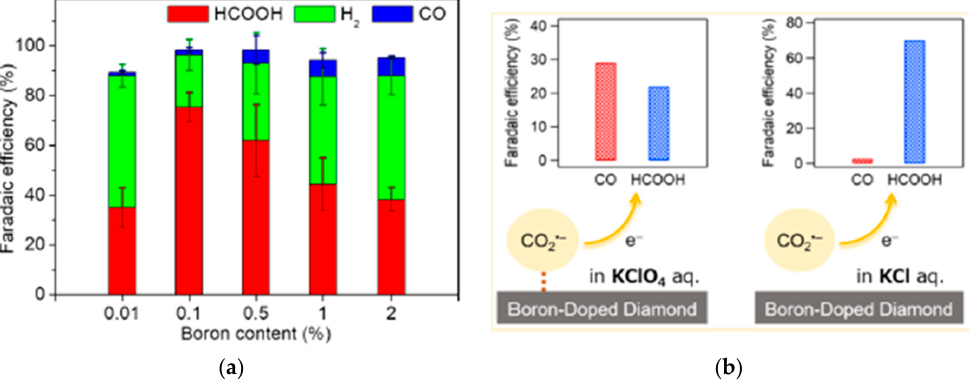
Figure 3. ( a ) Faradaic e ffi ciencies to formic acid, hydrogen, and carbon monoxide on boron-doped diamond (BDD) electrodes with various boron contents, reproduced from [103], Copyright (2020), with permission from Elsevier. ( b ) E ff ect of the catholyte on the product selectivity and faradaic e ffi ciency of BDD, reproduced from [104], Copyright (2020), with permission from the American Chemical Society.